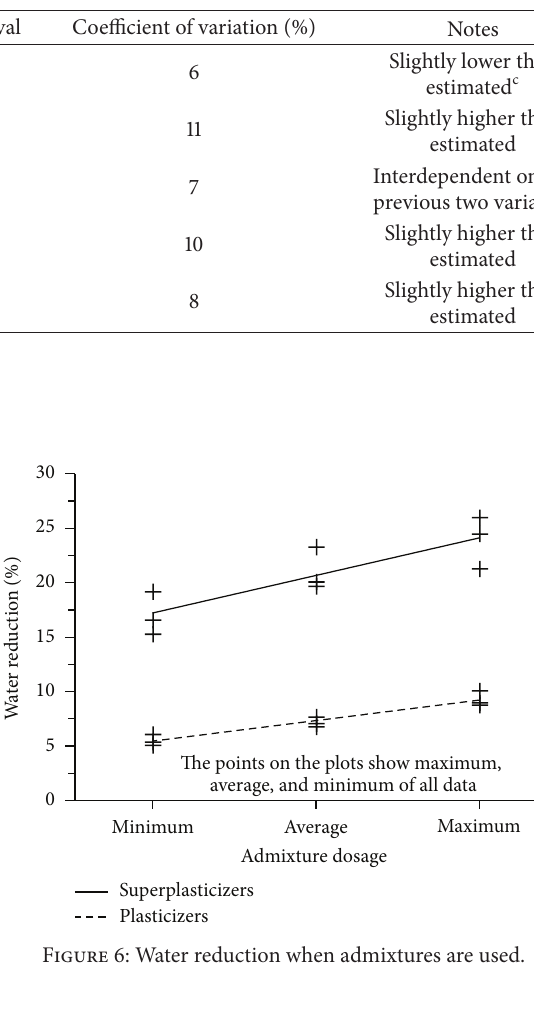
Table 4: The results of 220 mixes obtained during the 24 years of study.